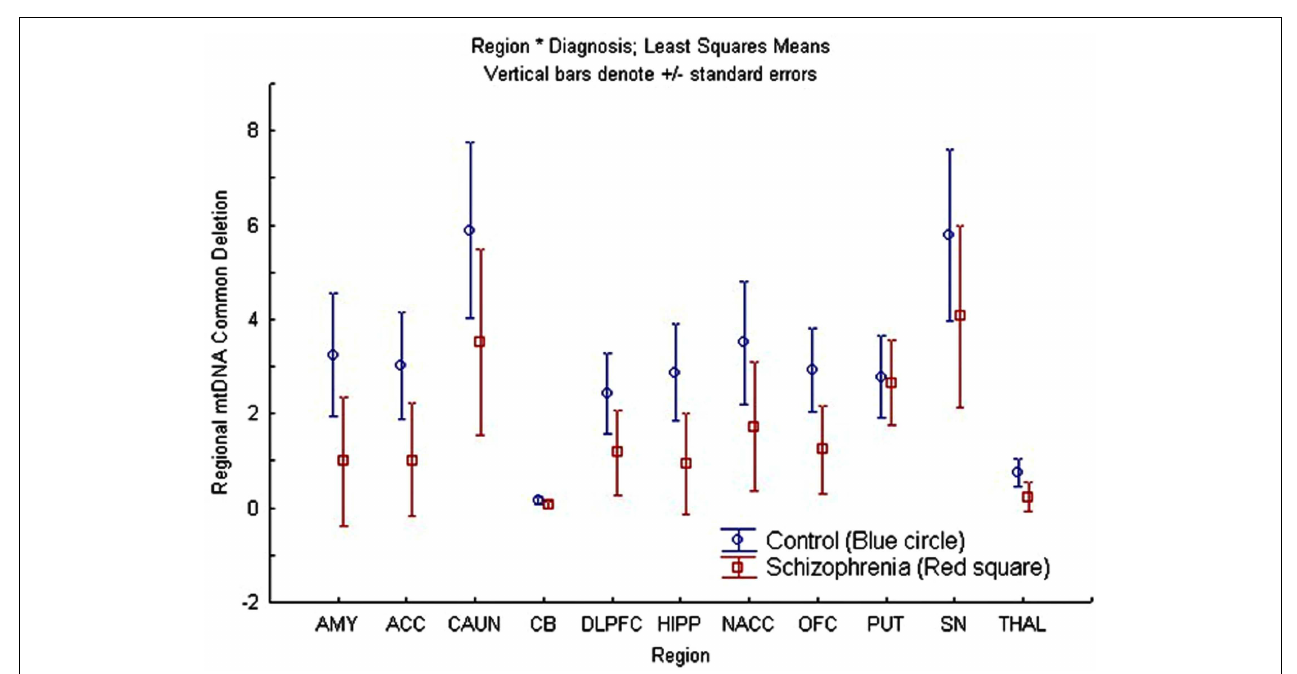
shows the least squares mean and standard errors of non-age-adjusted common deletion percentages per region, plotted by diagnosis in cohort 1 (schizophrenia compared to